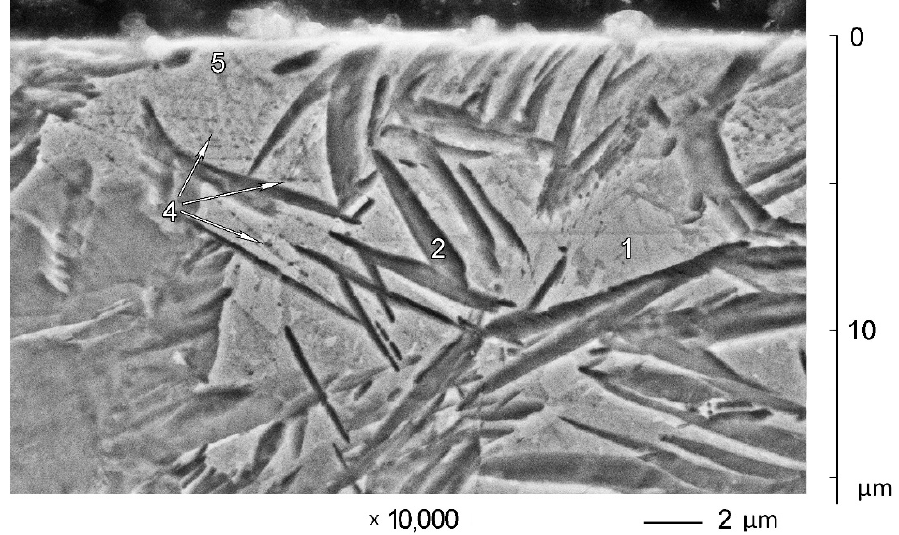
Figure 5. Microstructure of subsurface zones of X120Mn3Si2 steel after quenching from 1000 °C and wear in A mode: 1—austenite; 2—martensite; 4—etch pits; 5—surface zone formed by abrasive wear.